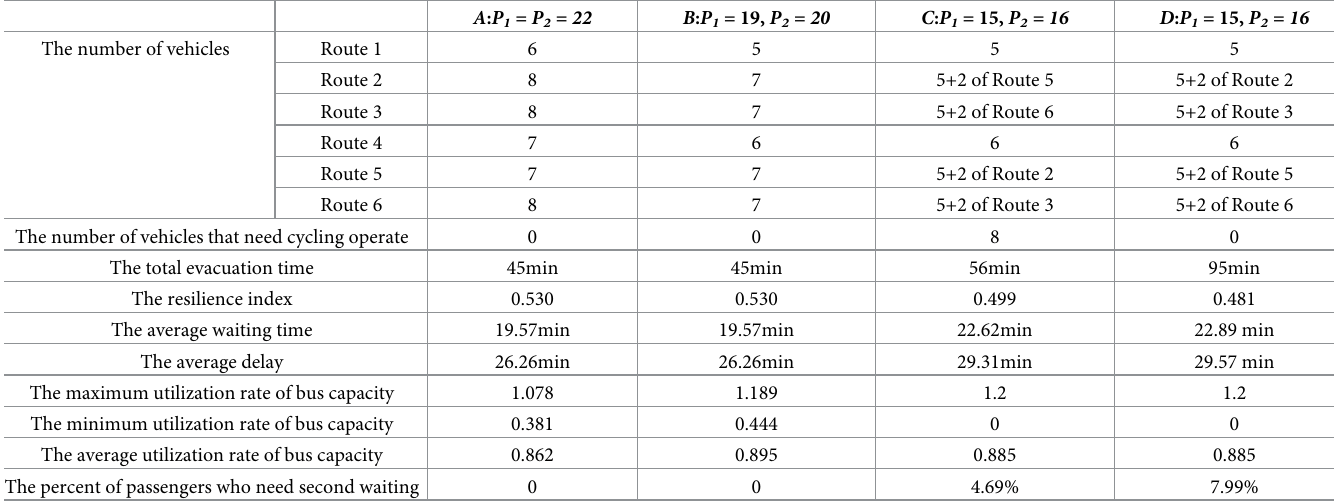
Table 5. The sensitive analysis of the number of available bus